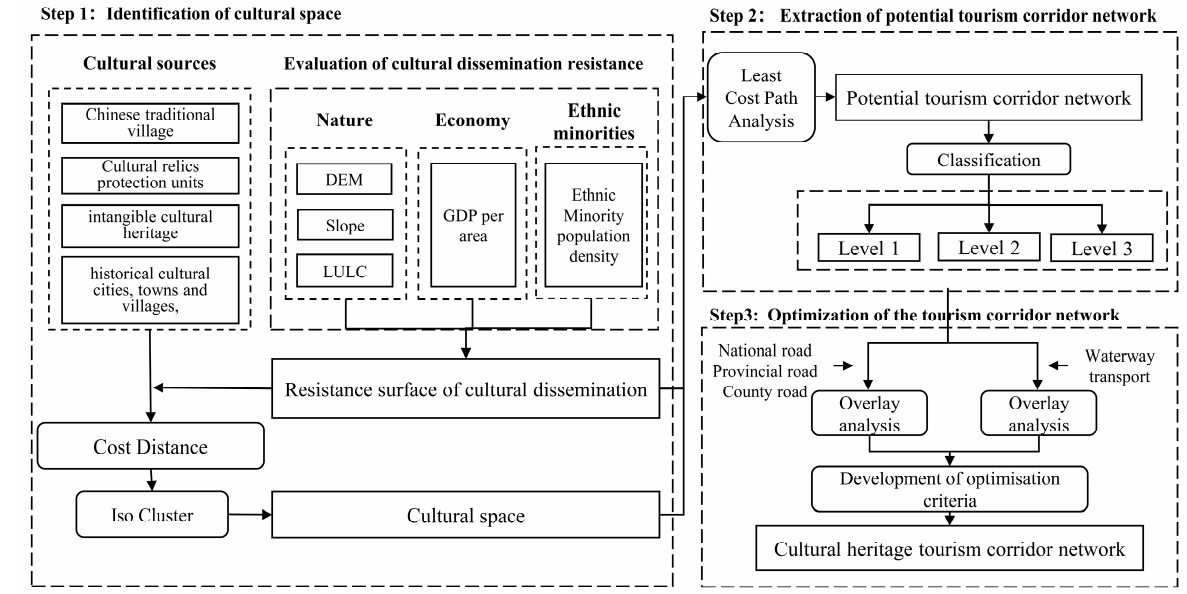
Figure 2. Research framework. Table 1. Data information including type, time, acquisition, and